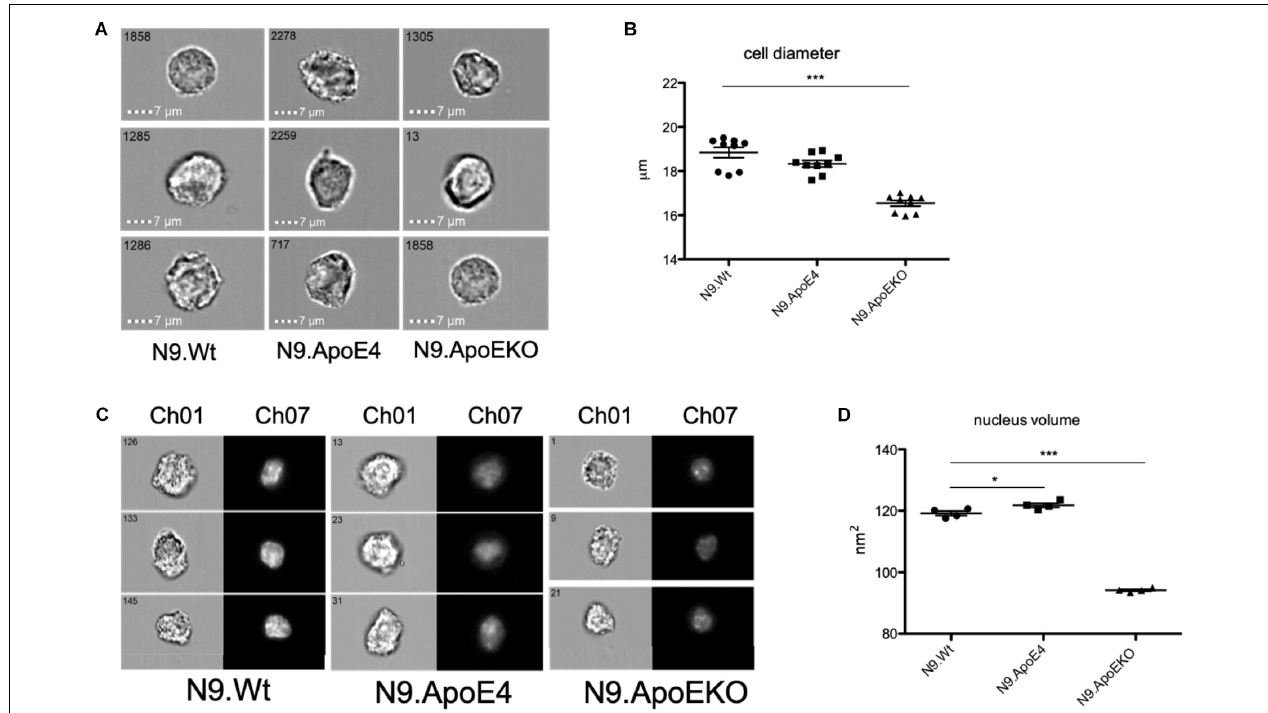
FIGURE 3 | ApoE4 leads to an increase in nucleus volume and cell diameter. (A) Cell diameter of 5000 cells of each ApoE-isoform was measured at a magnification of 40 × . N9.ApoE4 demonstrate an increase whereas N9.ApoEKO show a decrease in cell diameter in comparison to the other cell lines. (B) Quantification of cell diameter of five independent experiments ( n = 5) was done with AMARIS software. (C) Representative images of the pictures taken with imaging flow cytometry. 5000 cells were measured at a magnification of 40 × . Ch01: bright-field; Ch07: DAPI. (D) Quantification of nucleus volume with AMARIS software showed an increase in N9.ApoE4, whereby N9.ApoEKO display a decrease in comparison to N9.ApoE3 and N9.ApoE4 ( n = 6). Statistical significance was set up at ∗ p < 0.05 and ∗∗∗ p <